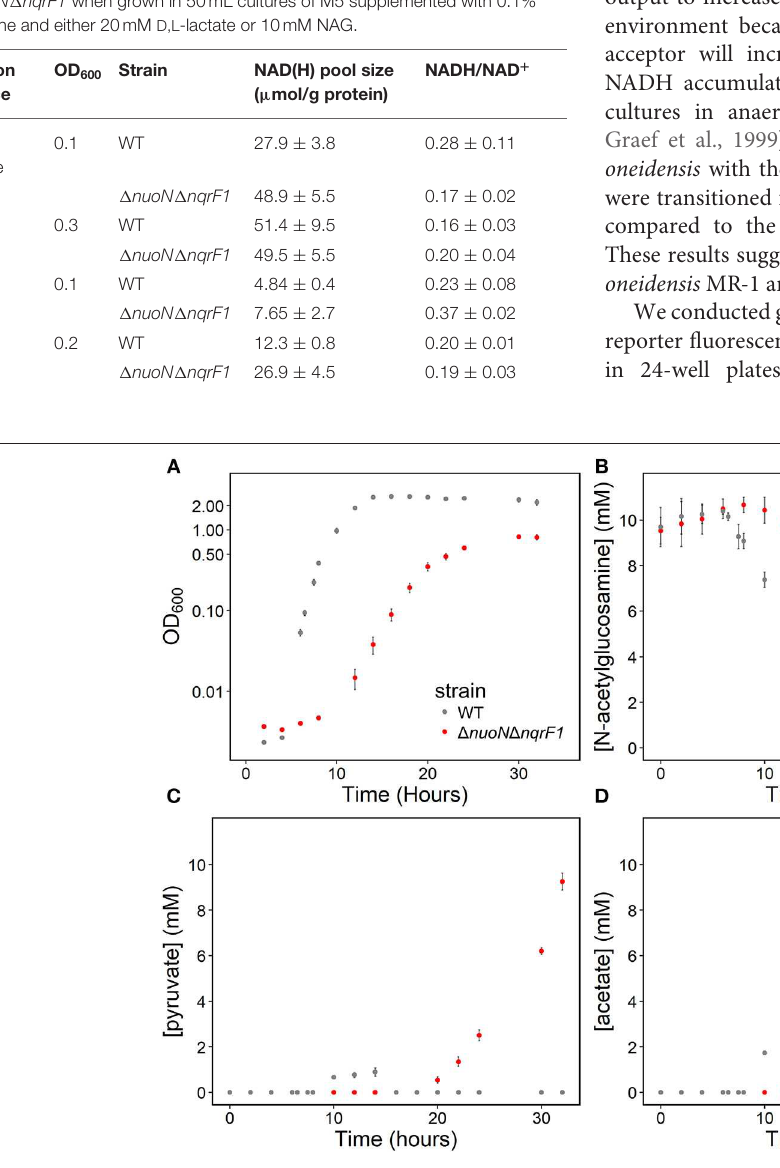
Frontiers in Energy Research |